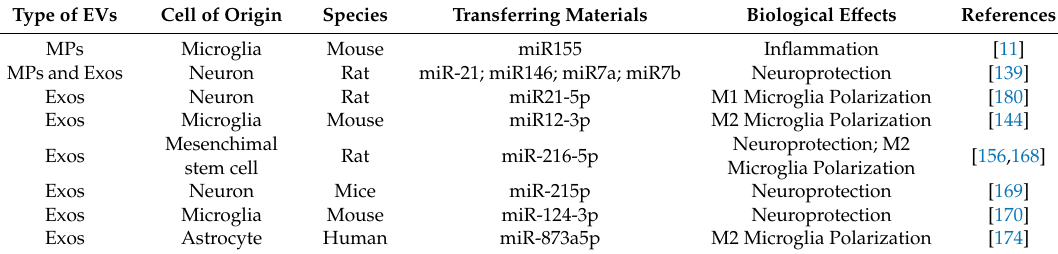
Table 1. Immunoregulatory potential and e ff ects of